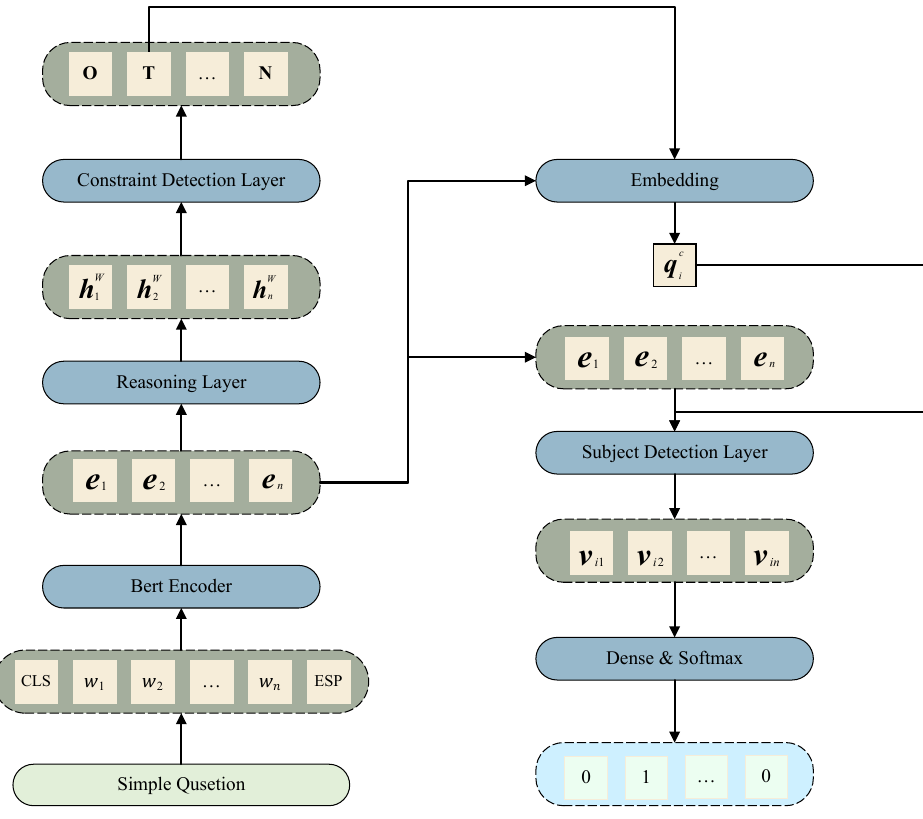
Figure 4. Question constraint extraction